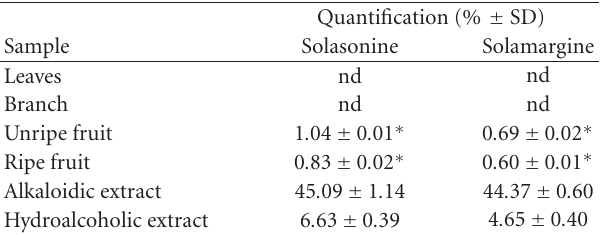
Table 5: Quantification of glycoalkaloids in di ff erent tissues of Solanum lycocarpum and in fruit